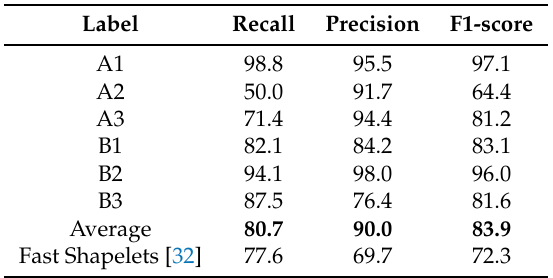
Table 6. The performance of classification on the BLUED dataset. Label